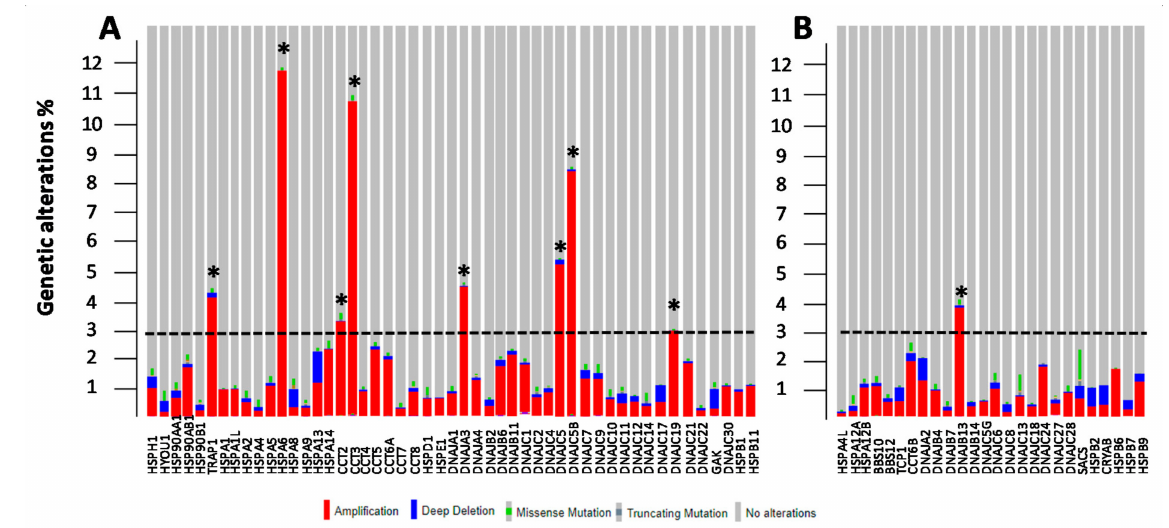
Figure 2. Analysis of genetic alterations in HSP members differentially expressed in BC. The percentage of alterations in HSP genes was extracted by using the OncoPrint tool of cBioPortal containing sequencing data of 2509 patients. Red and blue represent amplification, and deep deletion, respectively, green and grey represent missense and truncating mutations. Asterisk * indicates the corresponding HSP members showing a percentage of alteration higher than 3%. Histograms showing the percentage of genetic alterations of HSP genes up-regulated ( A ), and down-regulated ( B ) in